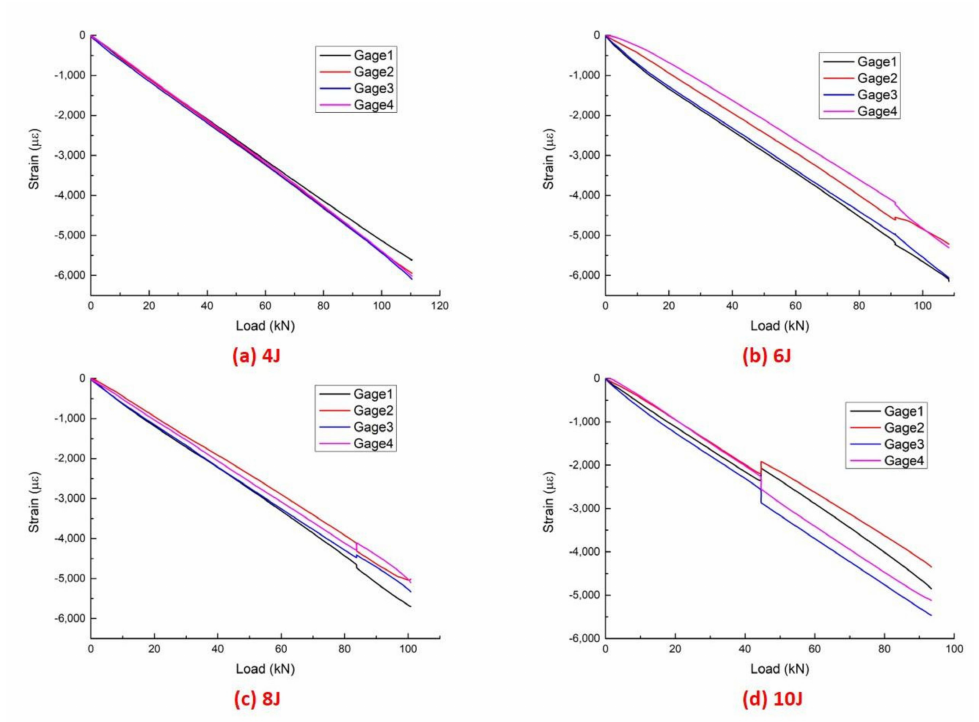
Figure 10. The strain–load curves of CAEI tests under different incident